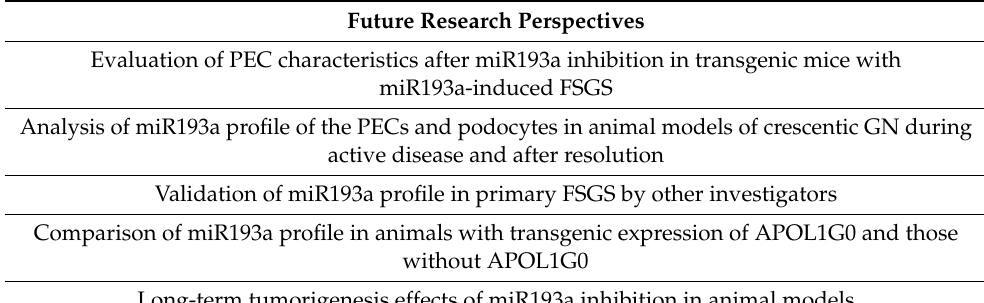
Table 1. Future Research